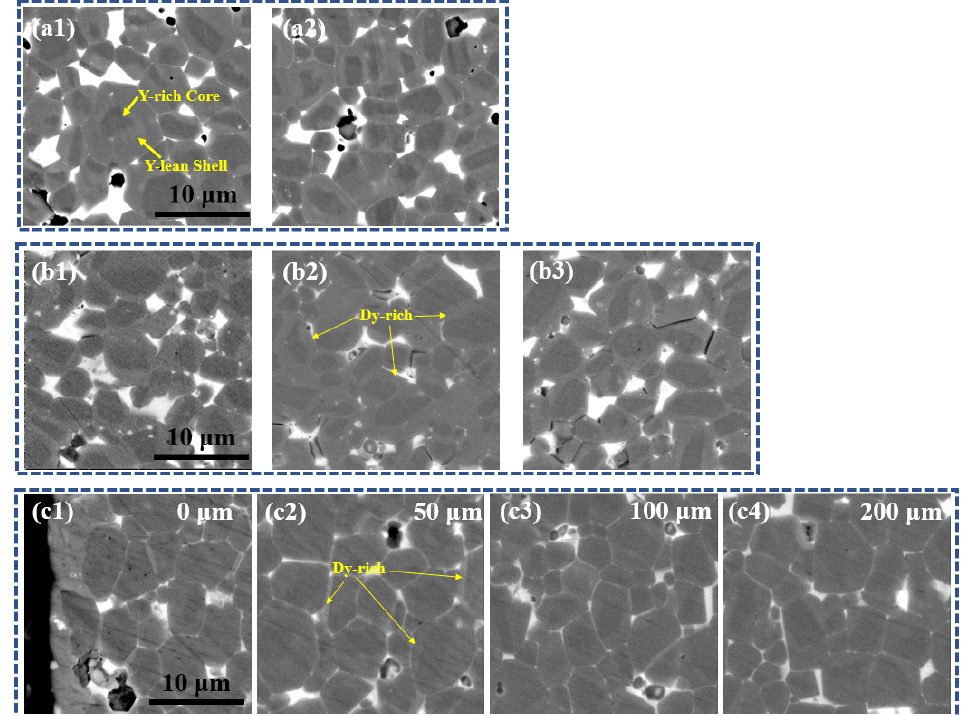
Figure 3. The microstructures of the original magnet, DyH x addition magnet, and the DyH x diffusion magnet. ( a1 , a2 ) are two different positions of the original magnet, ( b1 – b3 ) are three random positions in the DyH x addition magnet, and ( c1 – c4 ) are the microstructures at the depths of 0 µ m, 50 µ m, 100 µ m, and 200 µ m from the surface of the DyH x diffusion magnet, respectively.